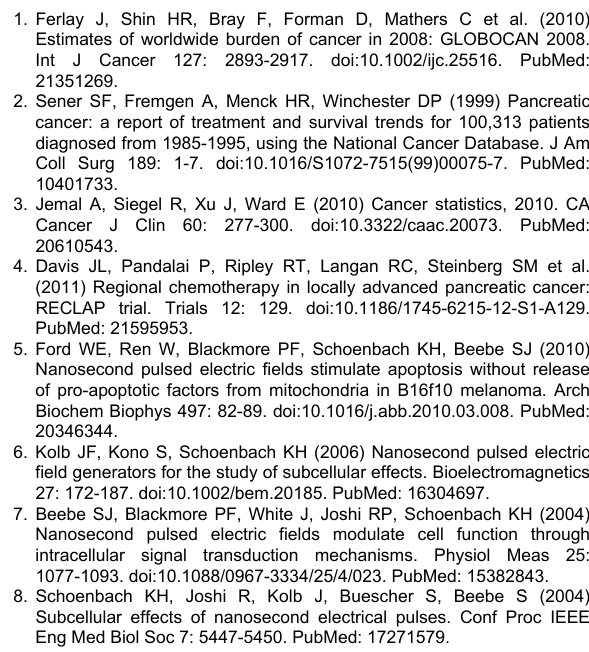
Figure S1. Equipments of nsPEF generator for cancer cells and tumor tissue. (A) The whole equipment of